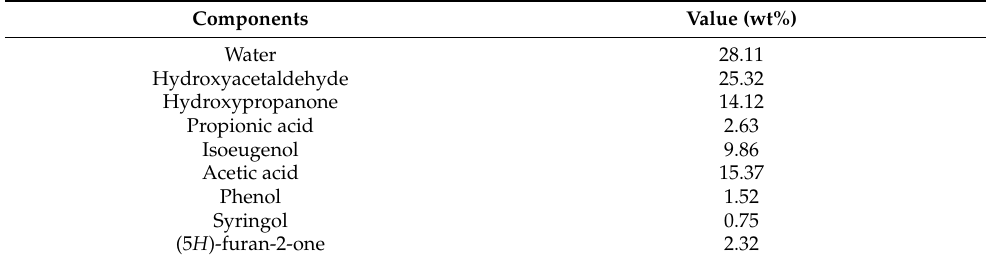
Table 1. Simulation results for the components of the bio-oil.